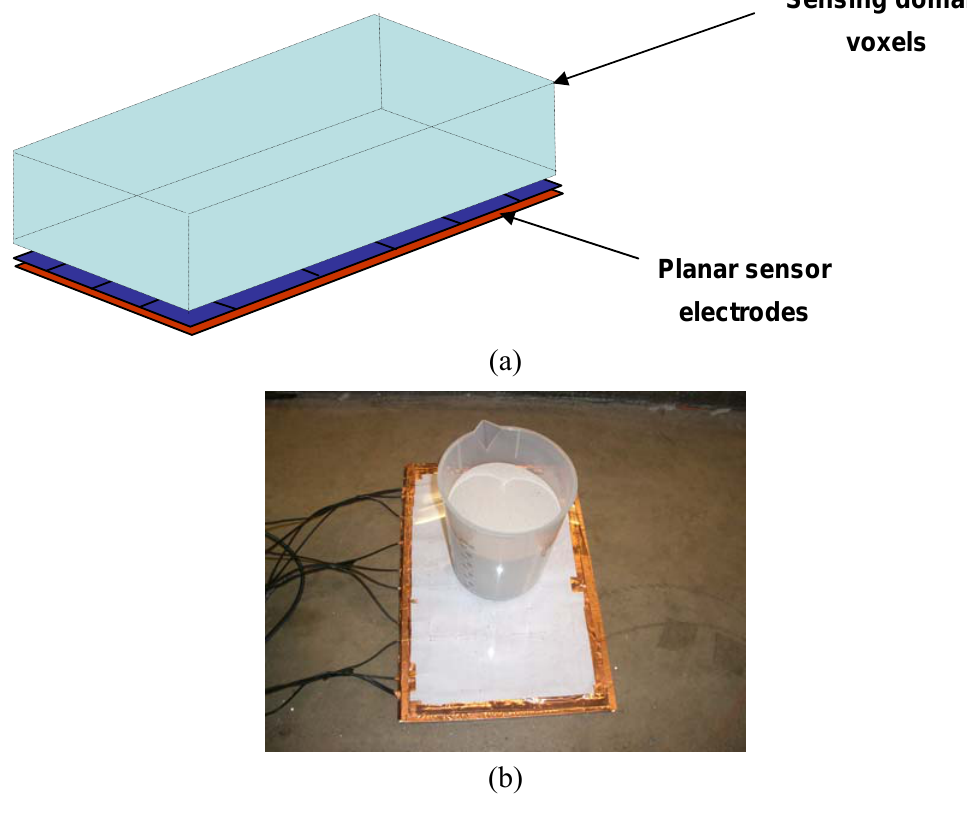
Figure 9. Planar ECVT sensor: (a) configuration of the sensor; (b) photo of the planar sensor with a testing object; (c) tomographic image from the planar